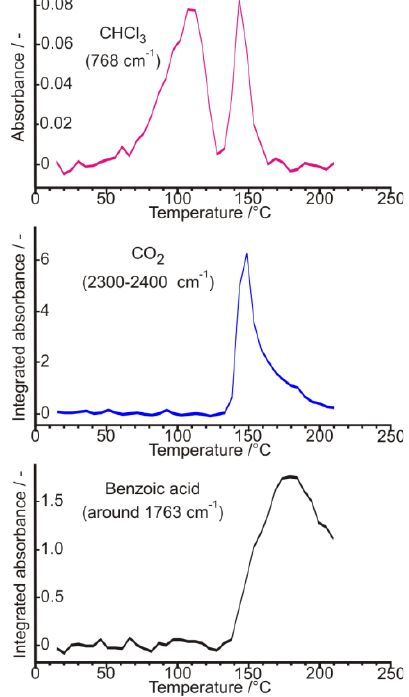
Figure 30. Integrated absorbance vs. temperature (as ‘evolution rate’) curves of released various gaseous species, from the air-dried diastereomeric salt, during a TG-EGA-FTIR spectroscopic evolved gas measurement at a heating rate of 10 °C/min. Note the two-stage evolution course of chloroform (Figure based on Ref. [15]).